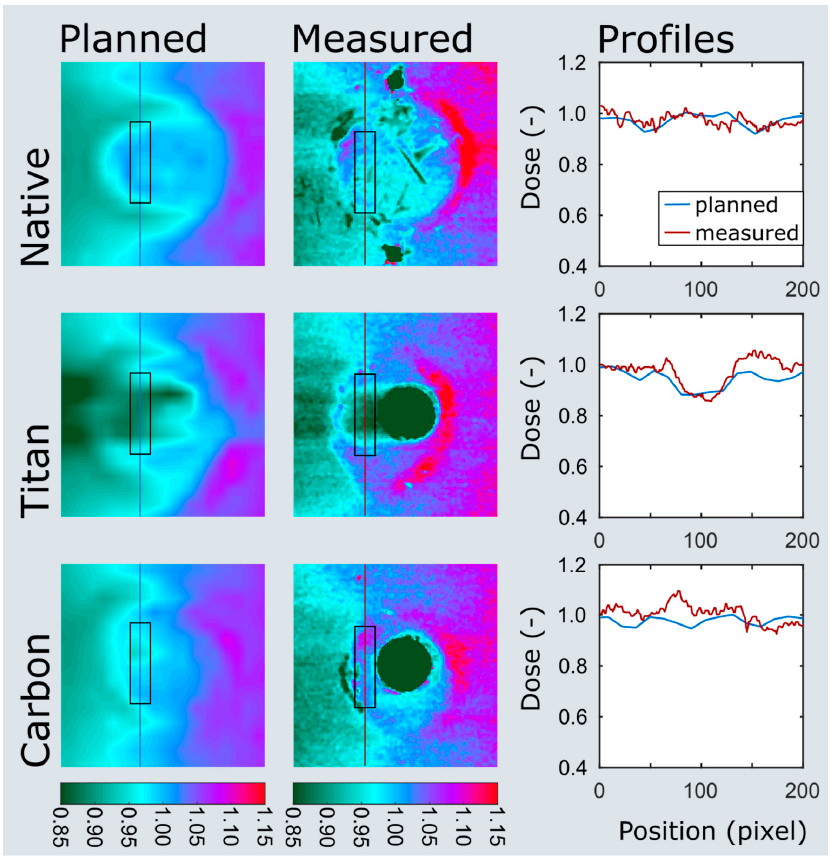
Figure 6. Dose plotting of the nail model at 5 cm immersion depth. The area of interest and profiles are depicted on the planned and measured dose distributions as black boxes and colored lines. Note the clear dose attenuation behind the titanium nail (titan) when compared to the CF / PEEK nail